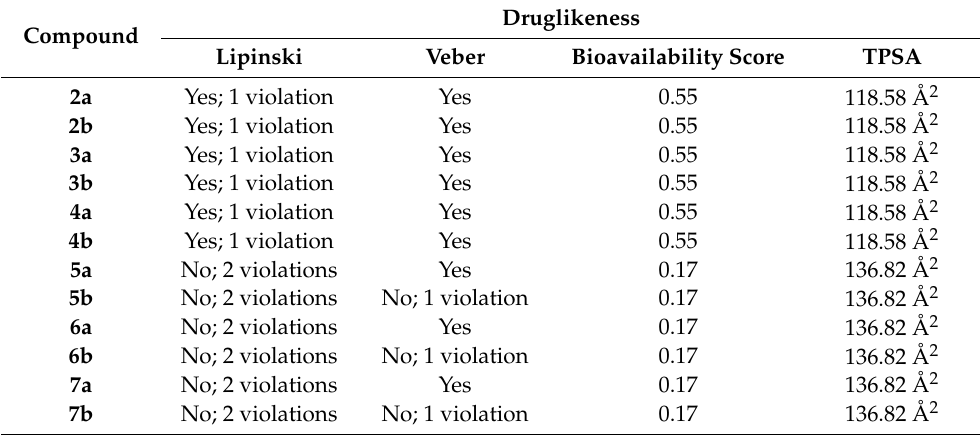
Table 4. Predicted druglikeness of investigated compounds using SWISSADME server (accessed 18 June